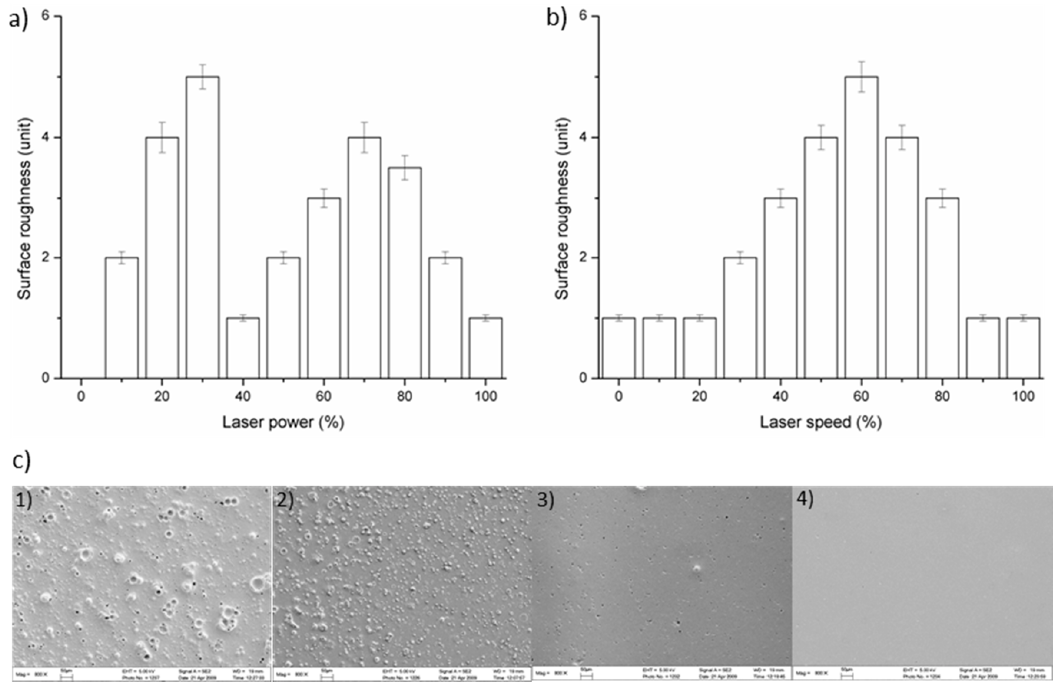
Figure 3. Laser ablation parameters for a PMMA chip surface were studied at different ( a ) laser powers and ( b ) laser speeds. The SEM images ( c ) show the surface patterns on PMMA under different laser power and speed ablating parameters. ( c1 ) Laser power 30% and speed 60%, P3-S6; ( c2 ) laser power 40% and speed 50%, P4-S5; ( c3 ) laser power 40% and speed 40%, P4-S4; ( c4 ) laser power 30% and speed 40%,